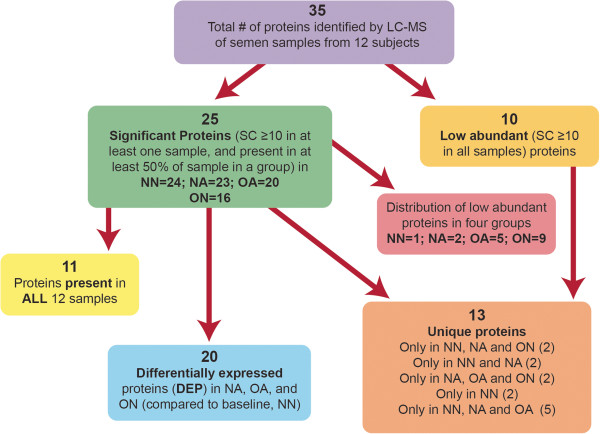
Broad categorical analysis of proteomics data. Differentially expressed proteins list encompasses proteins that overlap with other categories (common, unique, low abundant and significant) of proteins.